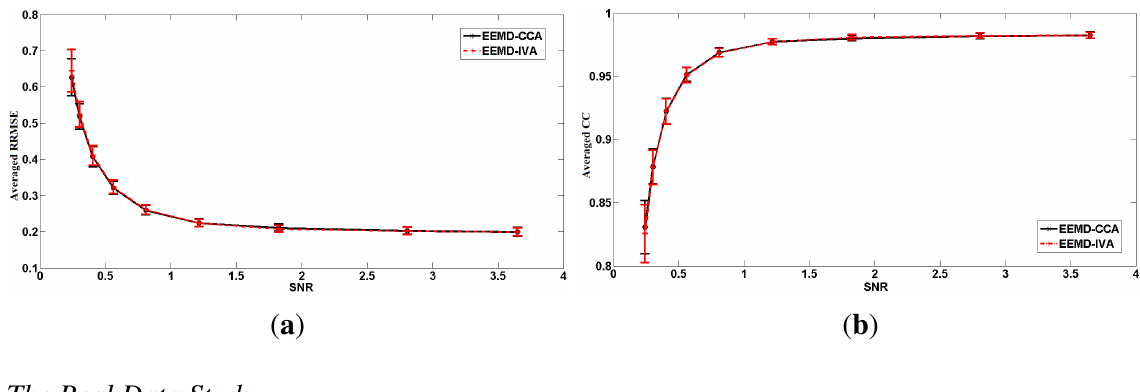
Figure 6. The performance measures for the two EEMD-JBSS methods at different SNR values for the simulated muscle activity case: ( a ) relative root-mean-squared error (RRMSE); ( b )